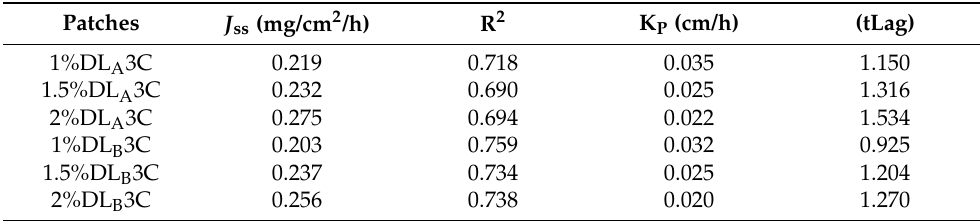
Table 2. Flux ( J ss ) linear regression (R 2 ), permeability coefficient (K p ) and lag time (tLag) of DS- medicated DL A 3C and DL B